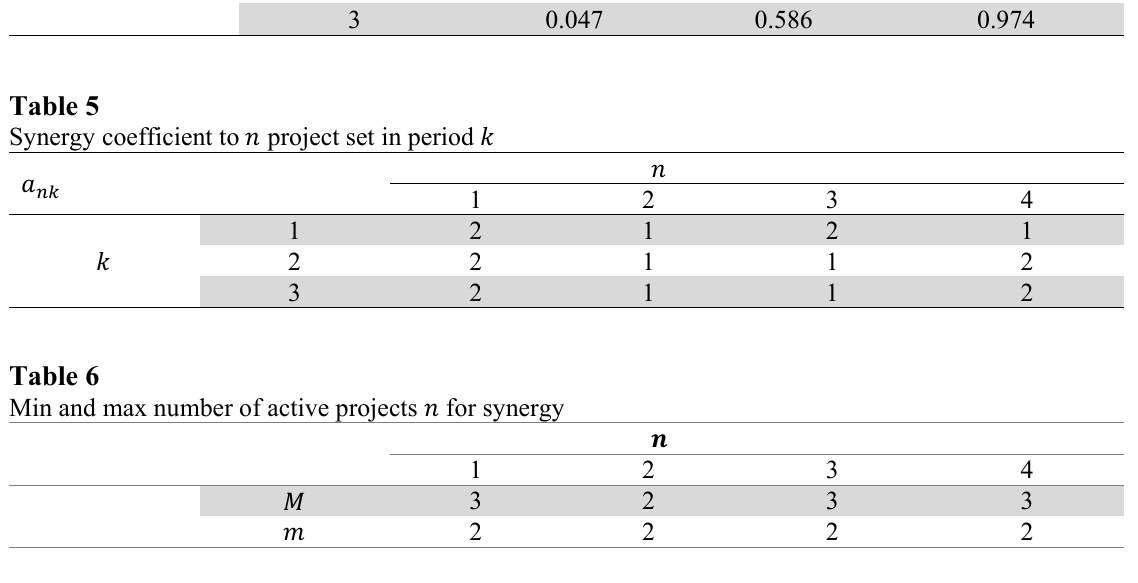
Weights enabling the aggregation of time-related information